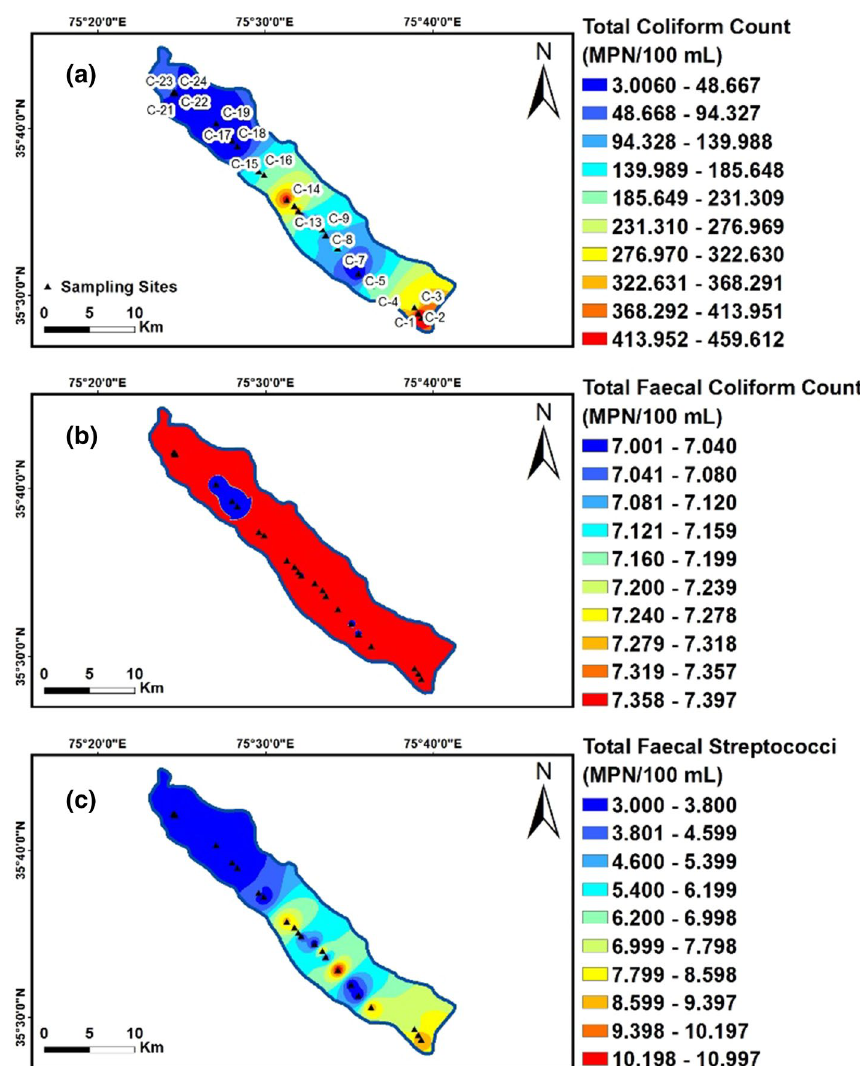
Fig. 10 IDW based spatial distribution of microbial param- eters a Total Coliform Count (TCC); b Total Faecal Coliform (TFC) Count; and c Total Fae- cal Streptococci (TFS) in Chu Tran Valley water